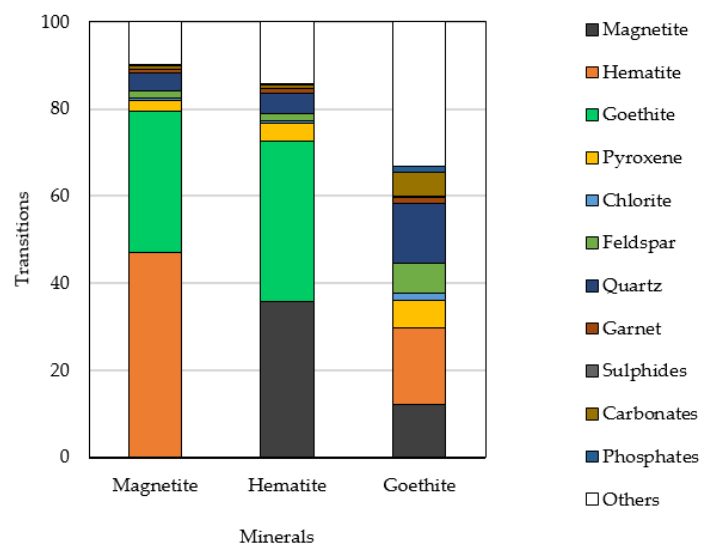
Figure 4. Mineral associations as determined by Quantitative Evaluation of Minerals by Scanning electron microscopy (QEMSCAN).